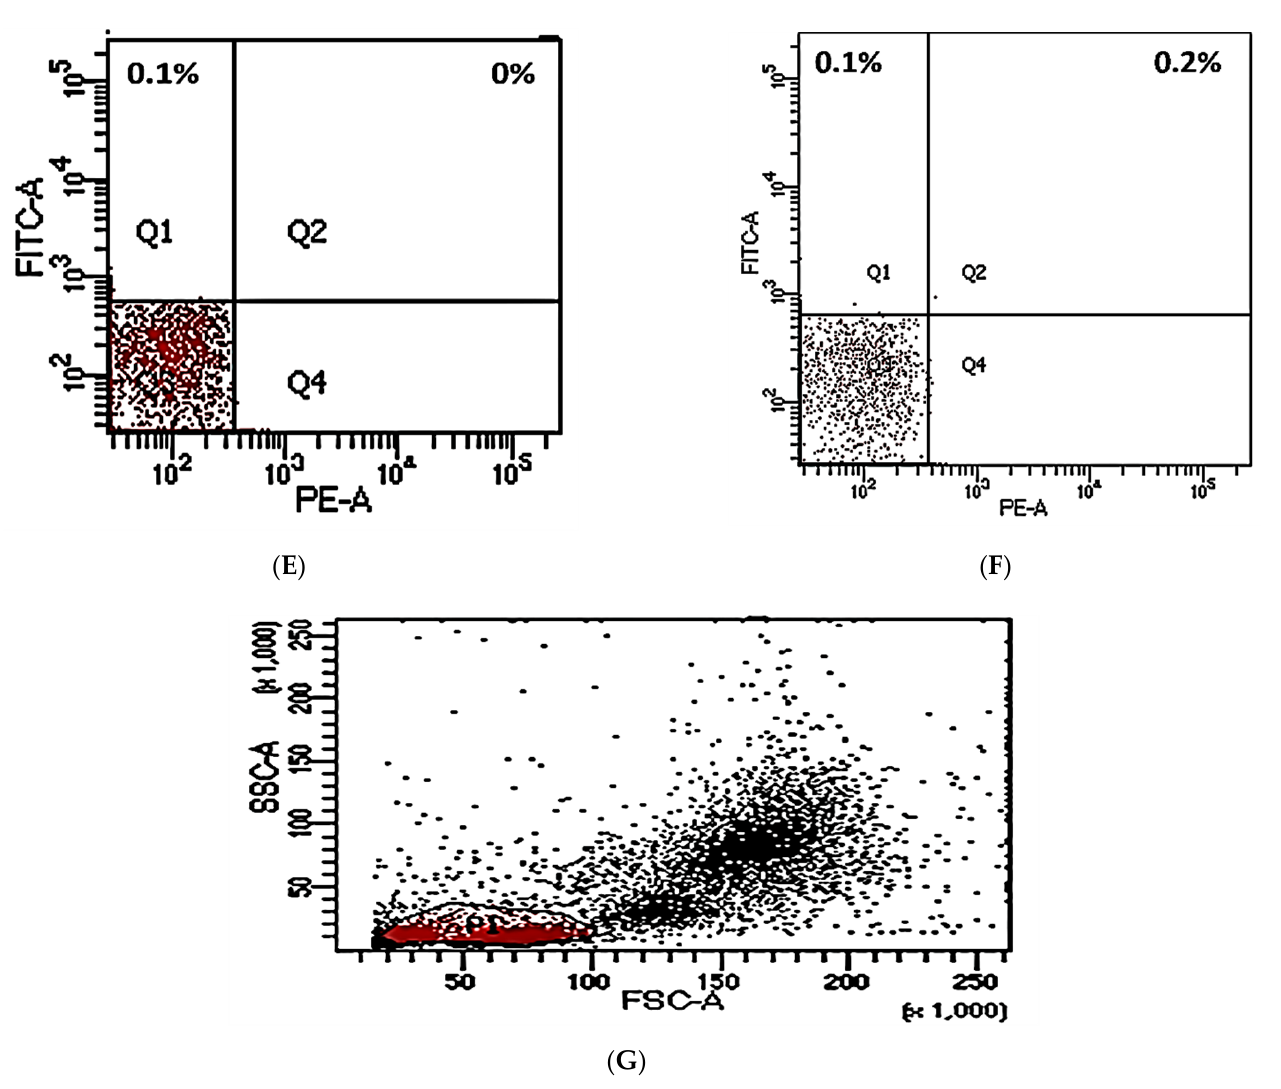
Figure 1. Flow cytometric plots for measurements of CD20+ %, PD-L1+CD20+ %, and PD-1+CD20+ Figure % of cells. CD20+ %, PD-L1+CD20+ %, and PD-1+CD20+ % within pre-therapy DLBCL patients ( A , B ); CD20+ %, PD-L1+CD20+ %, and PD-1+CD20+ % within post-therapy DLBCL patients ( C , D ); isotype-matched control for CD20 and PD-L1 ( E ); isotype-matched control for CD20 and PD-1 ( F ); gating used to detect cells for analysis ( G ). Table 3. CD20+ %, PD-L1+CD20+ %, and PD-1+CD20+ % in DLBCL patients and healthy subjects.